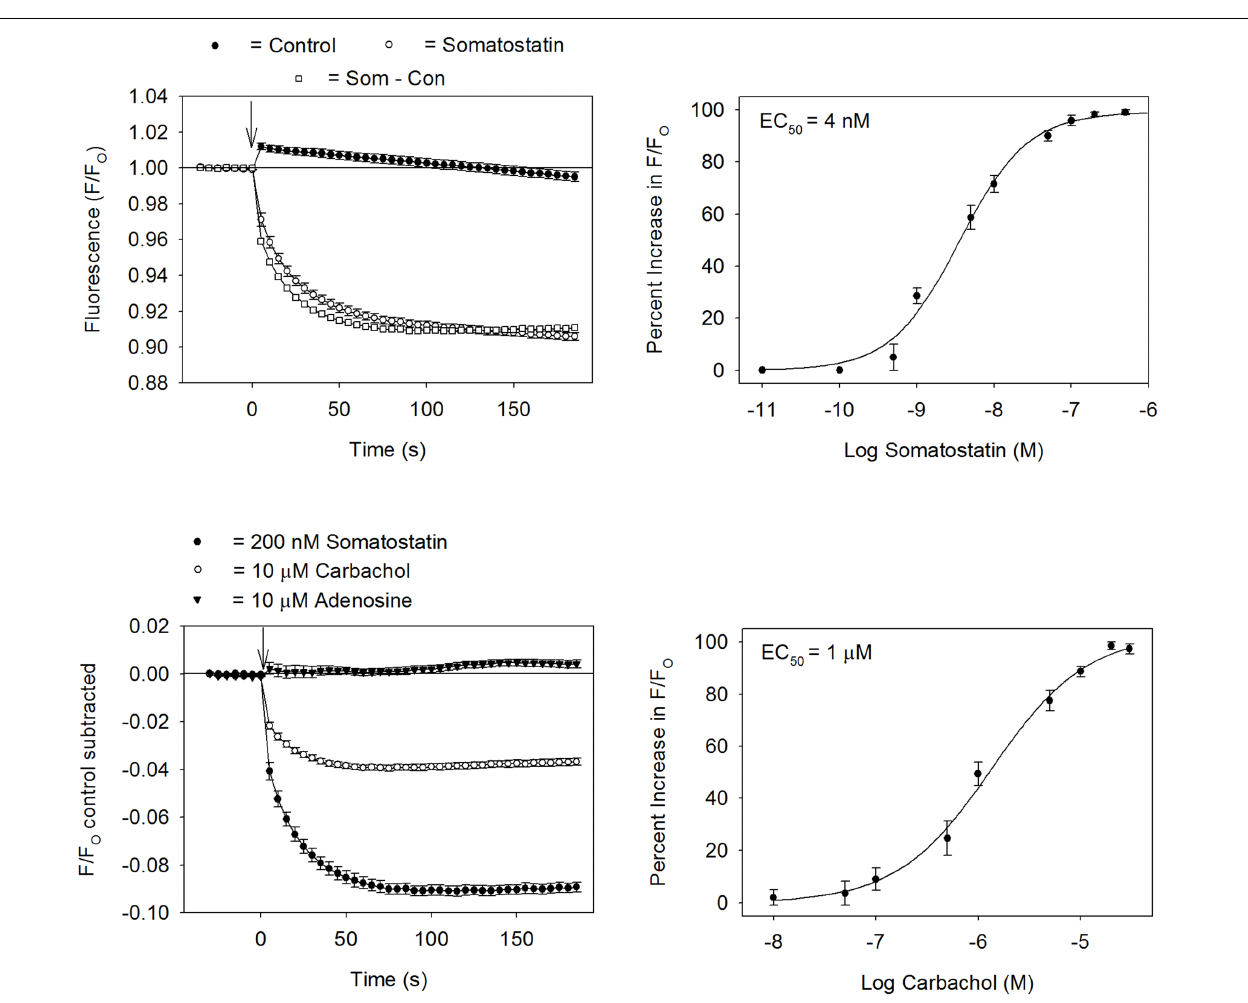
FIGURE 3 | Development of a GIRK channel blocker screening assay. Top left panel: HLB 021-152 fluorescent intensities obtained in AtT20 cells in the presence or absence of somatostatin.The ratio of the fluorescent intensity ( F / F O ) was calculated by dividing the signal in the presence ( F ) of somatostatin (or control solution) by the baseline signal measured before ( F O ) addition of somatostatin (or control solution). Each point represents the mean ± SE obtained in six to eight wells. Somatostatin was added at time